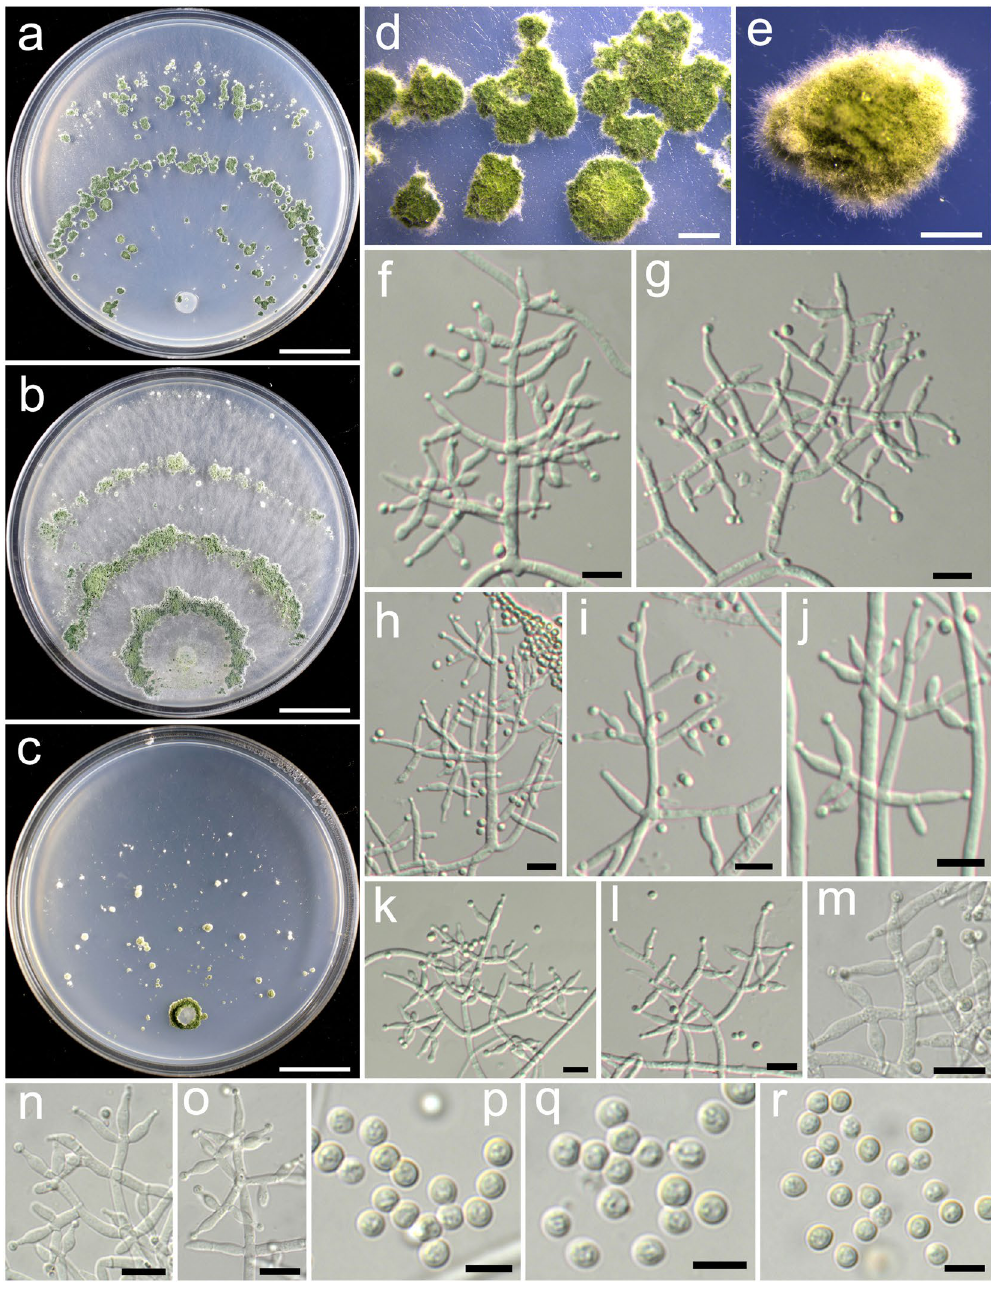
Figure 9. Trichoderma concentricum (HMAS 248833). ( a,c ) Cultures at 25 °C, 7 d (a. on CMD; b. on PDA; c. on SNA); ( d , e ) Conidial pustules (d. CMD, 7 d; e. SNA, 7 d); ( f – o ) Conidiophores and phialides (PDA, 6 d); ( p – r ) Conidia (p, q. PDA, 6 d; r. CMD, 6 d). Bars: a–c = 20 mm. d = 2 mm. e = 1.6 mm. f–o = 10 μ m. p–r = 5 μ